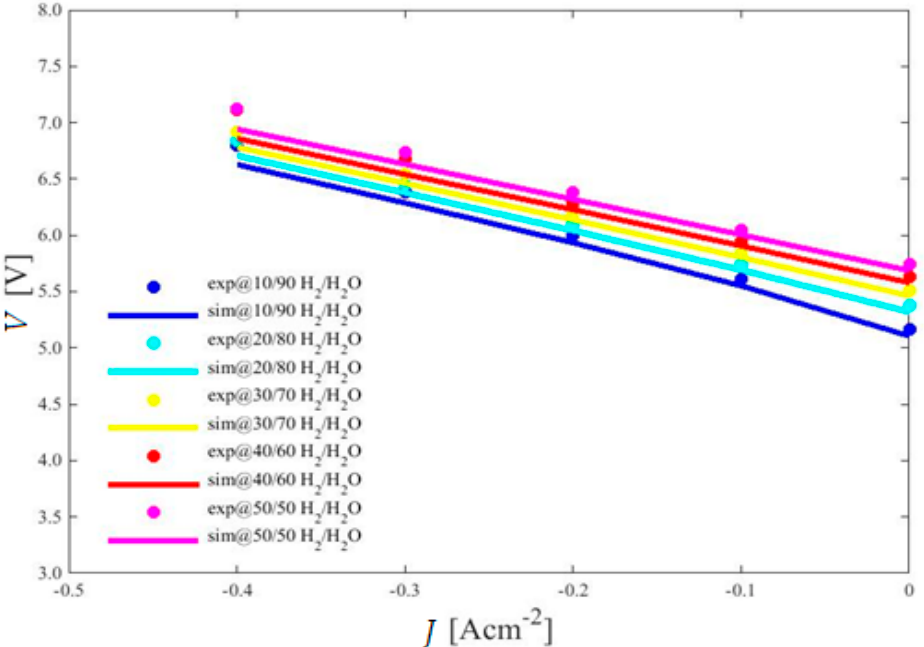
Figure 3. Polarization curves validation of a Solid Oxide Electrolyzer Cell (SOEC) short stack working at 1023 K though 2D isothermal modeling.